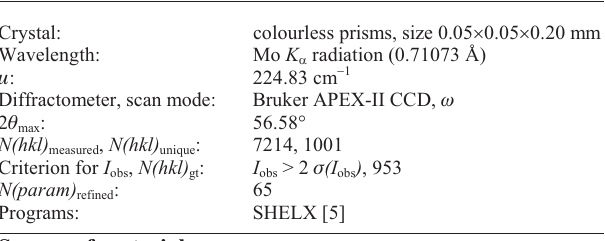
Table 1. Data collection and handling.